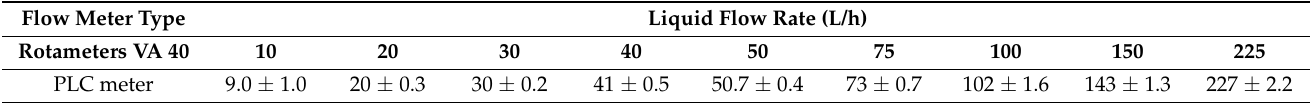
Figure 14. The exemplary types of floats. Table 1. The exemplary comparison of the flow rate values read on the rotameters and the PLC meter.